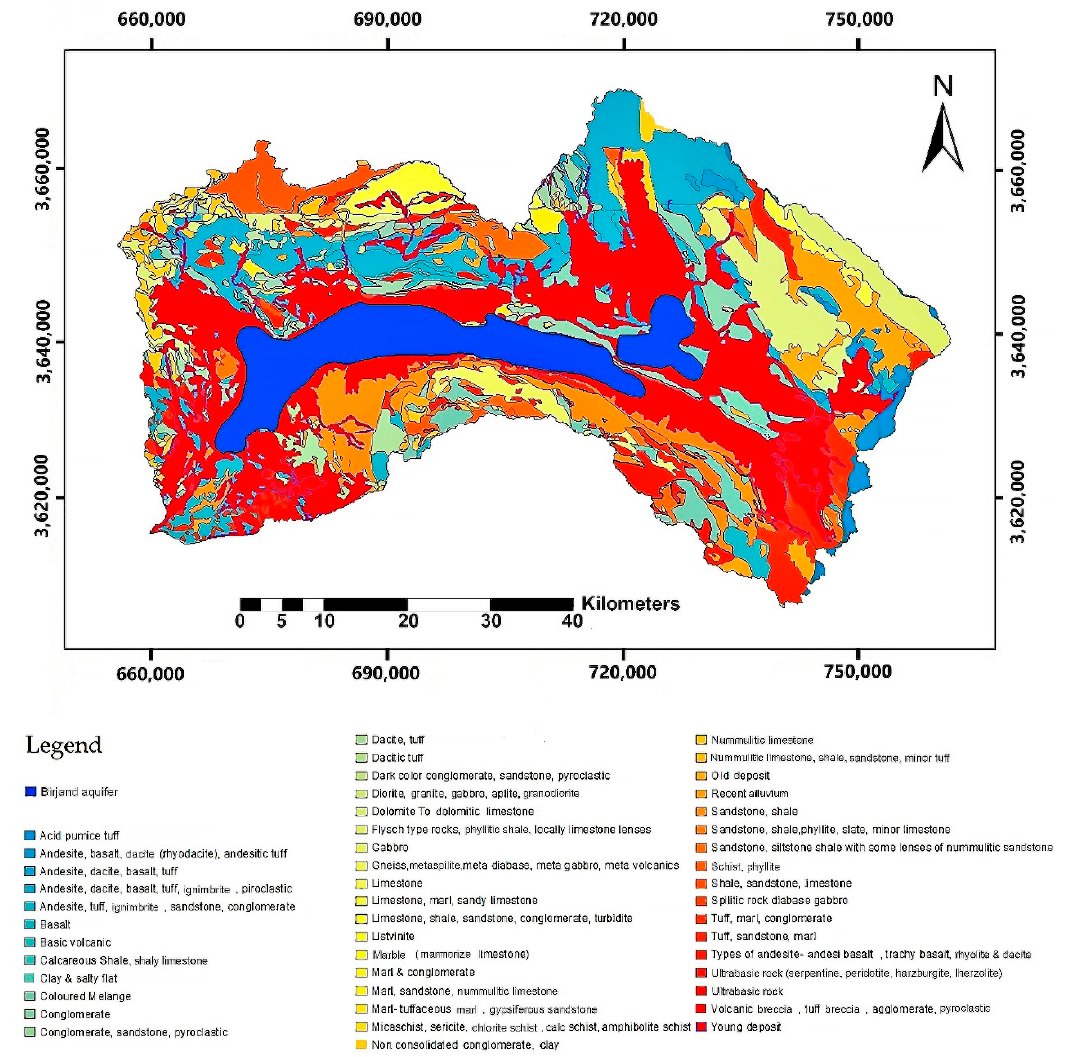
Figure 5. Birjand watershed geological map.